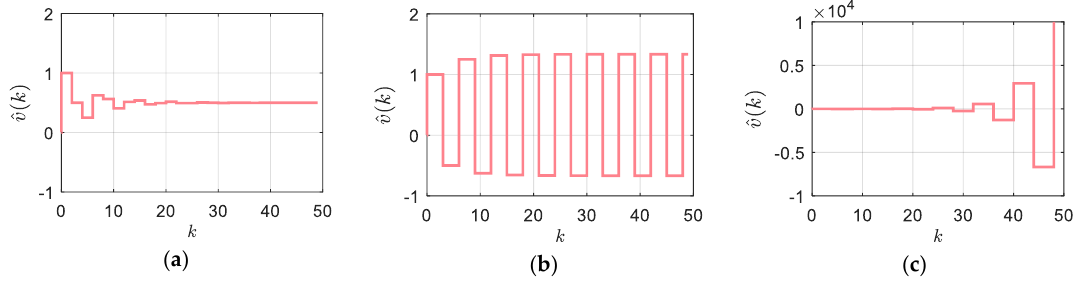
Figure 4. Step response of the DLMT filter in the case of blank sampling intervals (constant δ t k / T s = 0.5): ( a ) n i = 1; ( b ) n i = 2; ( c ) n i =